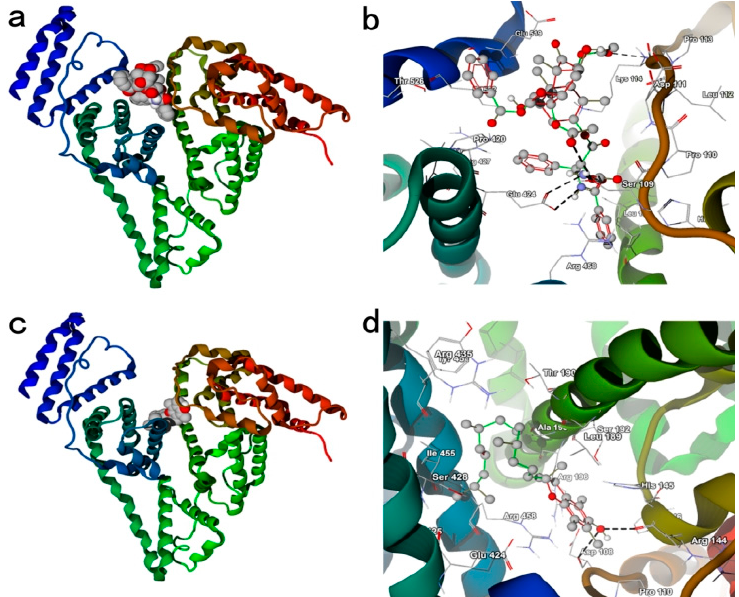
Figure 2. The molecular docking BSA with PTX ( a , b ) and VE ( c , d ).